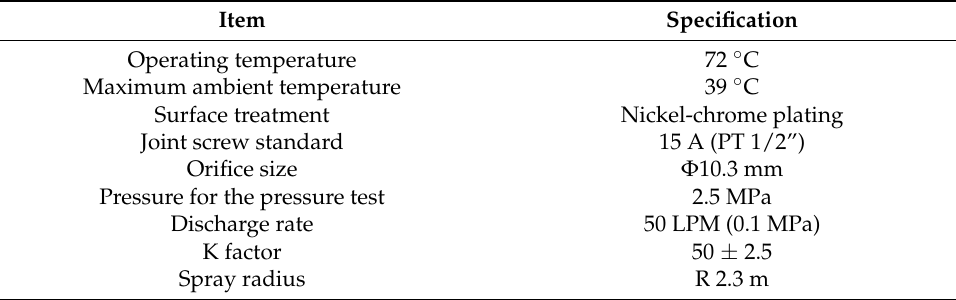
Table 2. Specifications of the simple sprinklers used in fire